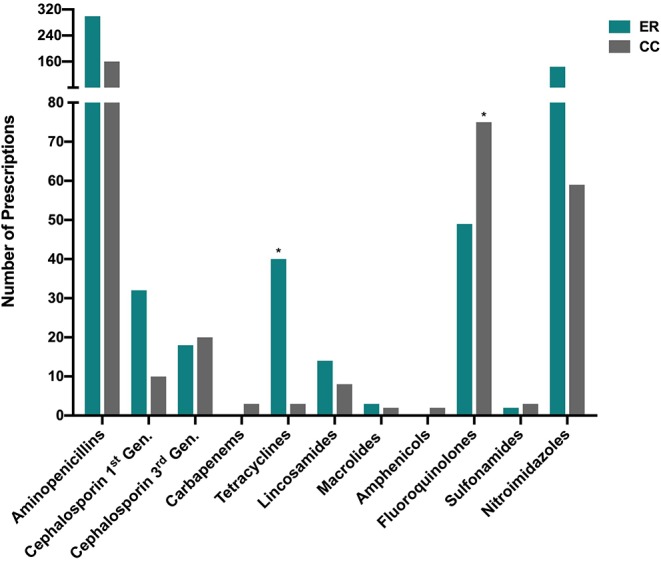
Distribution of drug classes prescribed by the Emergency Room (ER) and Critical Care (CC) services. The (*) symbol denotes that a significant difference (after correction for multiple comparisons) existed in the prescribing frequency of the labeled drug class between ER outpatients and CC inpatients (P < 0.0001). All classes prescribed are represented in the figure, i.e., drug classes for which zero prescriptions were recorded were omitted. Gen, Generation.